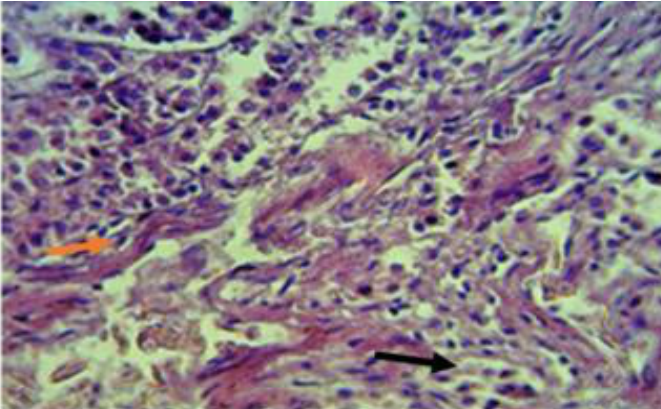
Figure 12. Histopathological section of kidney showing chronic interstitial nephritis characterized by presence of inflammatory